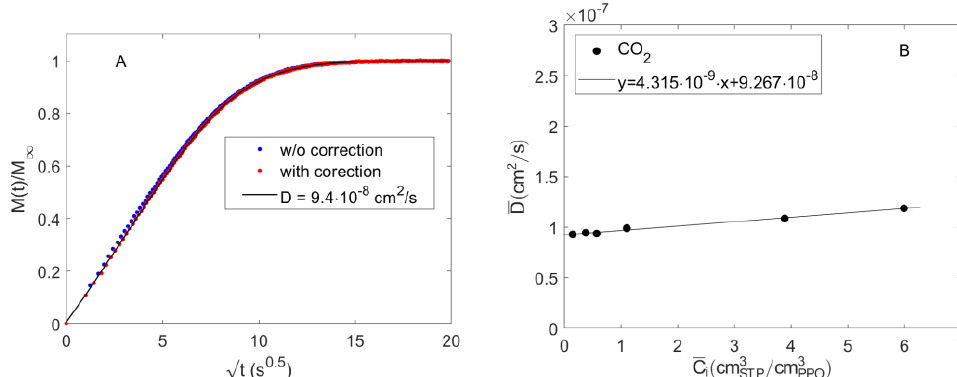
Figure 8. Sorption kinetics of CO 2 in amorphous PPO. ( A ) IR integral sorption kinetics up to 98.56 Torr at 35 °C with and without the gas phase correction reported in Equation (18). The black continuous line is the fitting from Equation (16); ( B ) estimated values of effective diffusivity of carbon dioxide in amorphous PPO as a function of average CO 2 concentration during each sorption step.